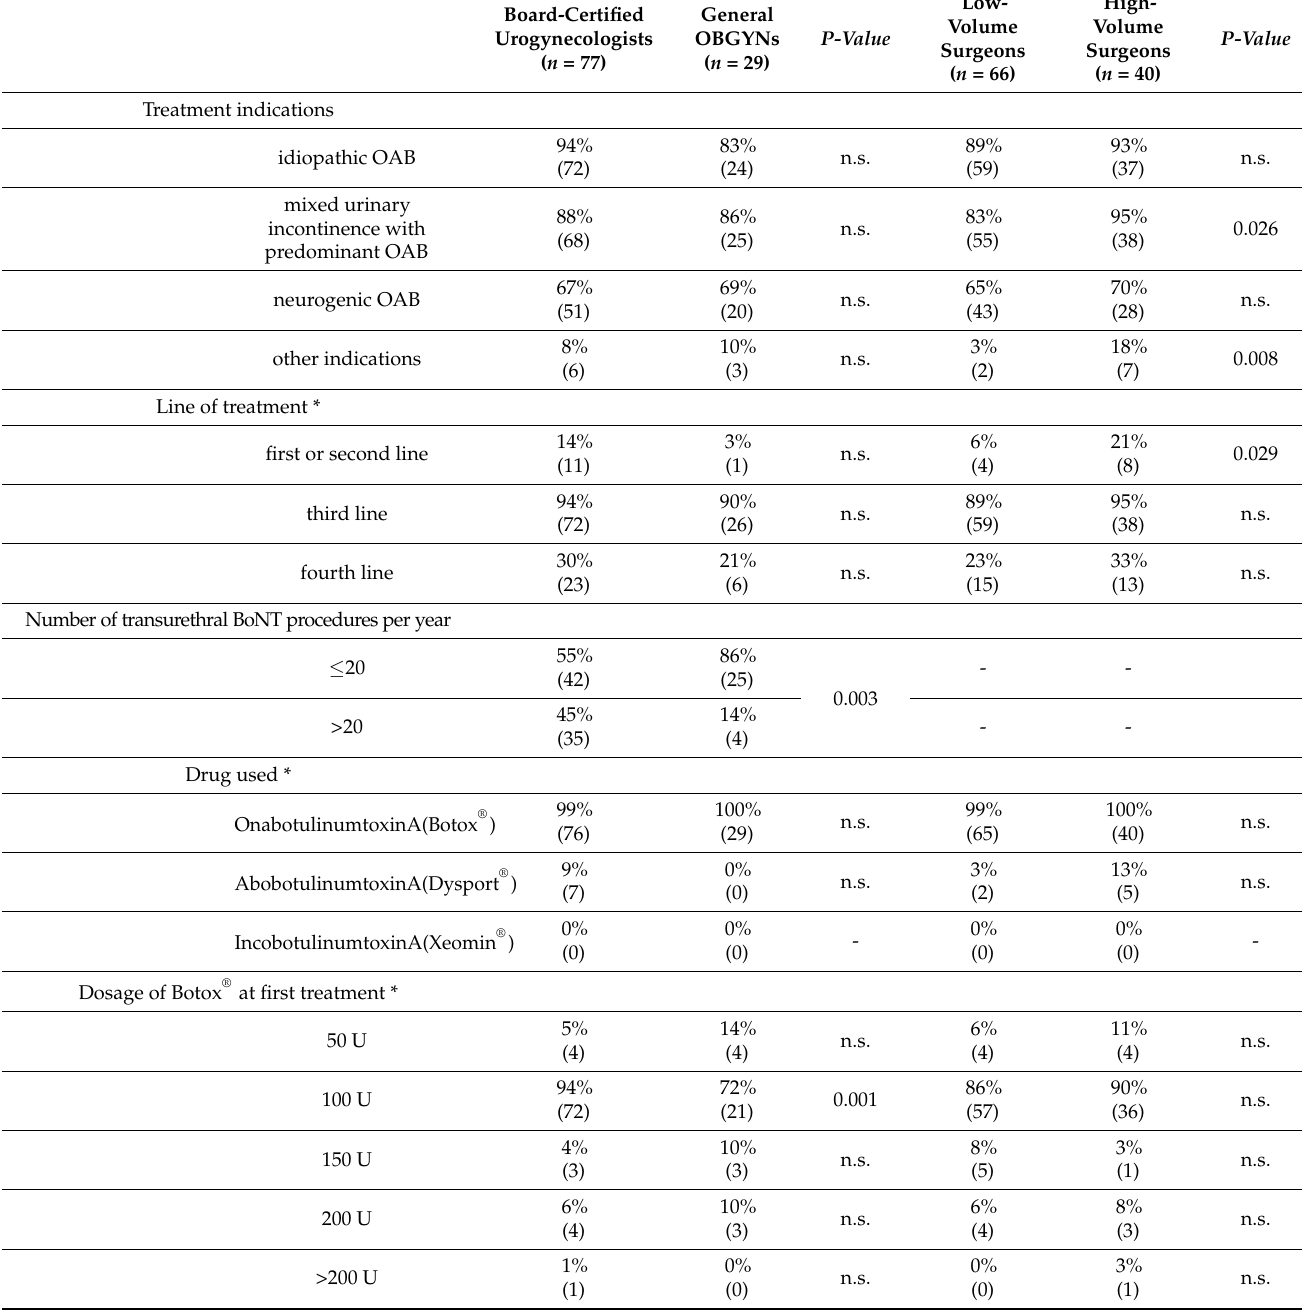
Table 2. Techniques of BoNT application, with comparisons between board-certified urogynecologists and general OBGYNs and between low-volume and high-volume surgeons. Percentages are given as ratios for each subgroup. * Cumulative percentages can be more than 100% because participants were allowed to give more than one answer. Cumulative percentages can be more than 100% because of rounding. BoNT = botulinum toxin, n.s. = not statistically significant, OAB = overactive bladder, OBGYNs = obstetrics and gynecologists. ◦ Cumulative percentage can be more than 100% because of